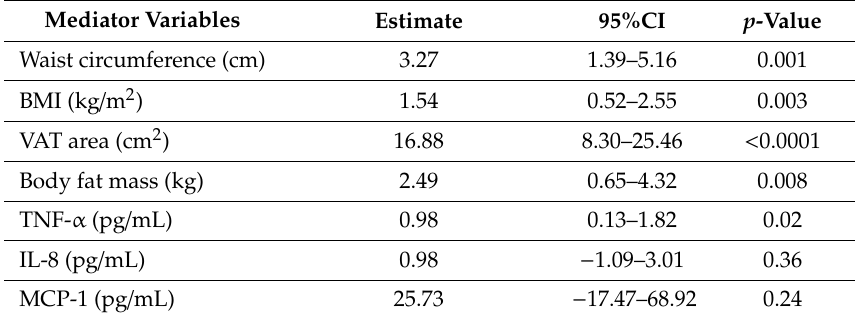
Table 4. Regression coe ffi cients (95% CIs) for the association between E-DII and measures of body composition and inflammatory cytokines in black SA